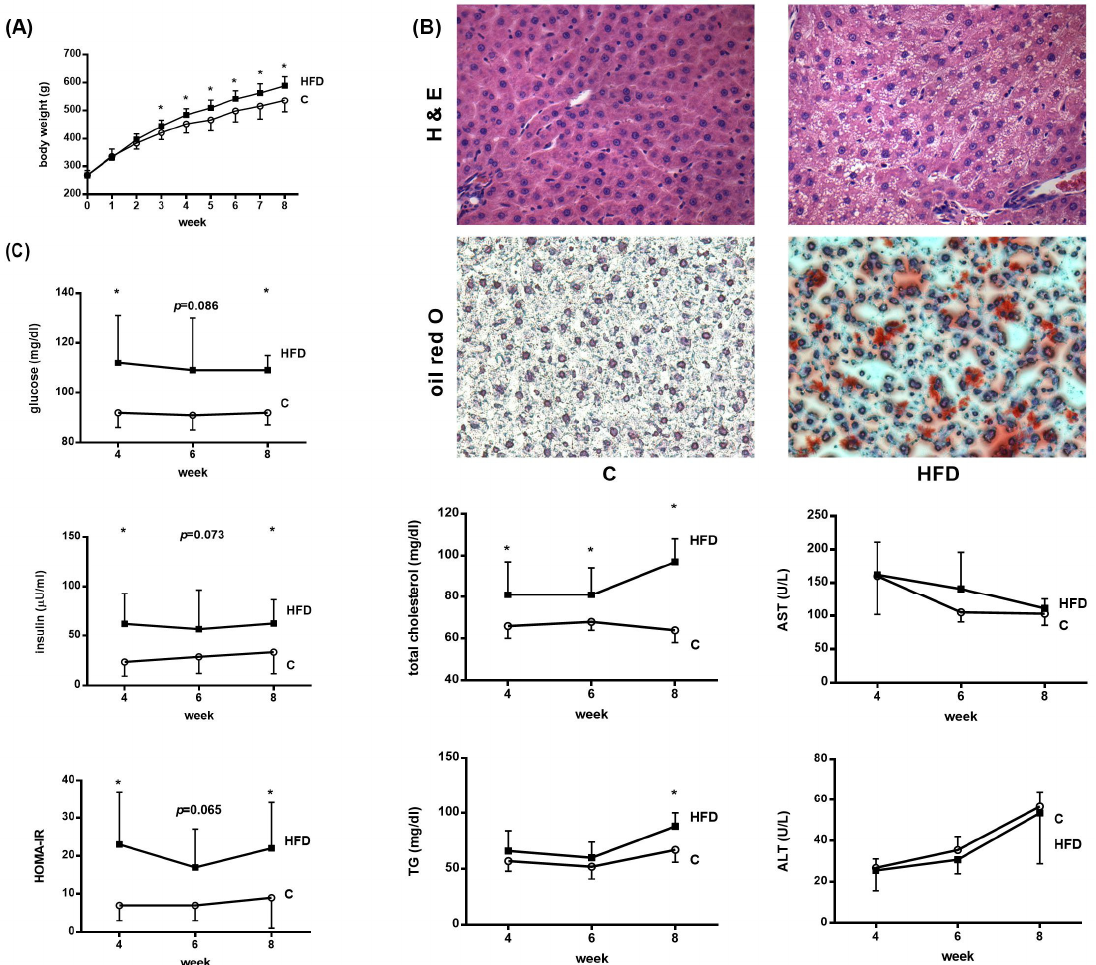
Figure 1. E ff ects of high fat diet (HFD) on liver biochemistry. Rats received regular chow diet (control, C) or HFD for 8 weeks. ( A ) Body weight increased significantly in HFD rats. ( B ) Liver histology showed marked ballooning change of hepatocytes and increased extent of oil red O staining, which is compatible with liver steatosis. (magnification: 20 × ) ( C ) The plasma glucose, insulin, HOMA-IR, cholesterol and triglyceride (TG) but not alanine aminotransferase (ALT), aspartate aminotransferase (AST) levels increased significantly in the HFD group. (* p <